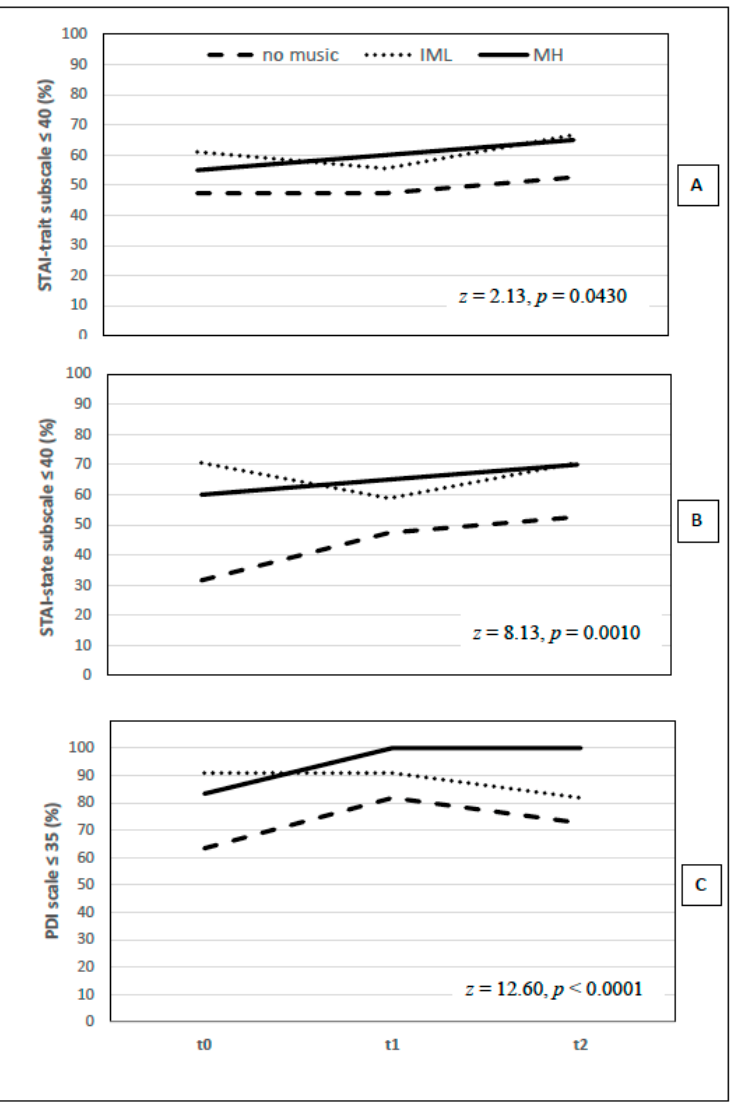
Figure 2. Proportion of patients with a State-Trait Anxiety Inventory (STAI, A , B ) or Psychological Distress Inventory (PDI, C ) scores below the critical value at baseline (t0), end of treatment (t1) and at follow-up (t2). Cochran’s Q test was used to evaluate if the proportion of patients having an anxiety score below the critical value for the STAI sub-scales and PDI scale changed over time, depending on the treatment. A p -value ≤ 0.05 was considered statistically